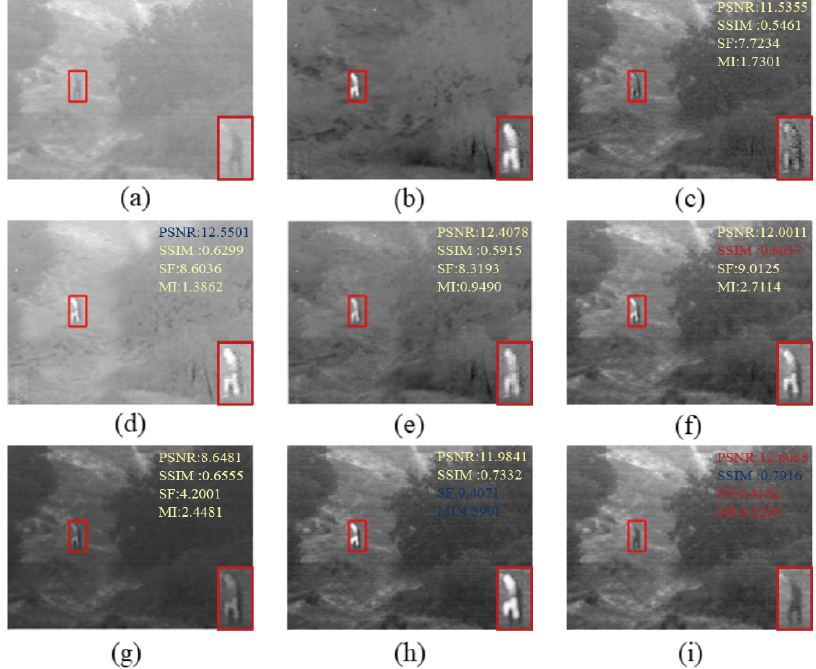
Figure 3. Qualitative comparison of LCF with six state-of-the-art methods on people. For a clear comparison, we select a salient region (i.e., the red box) in each image and enlarge it in the bottom right corner. In addition, the evaluation indicators are displayed on the top right, with red representing the best and blue the second best. ( a ) Visible image; ( b ) Infrared image; ( c ) LP; ( d ) GTF; ( e ) MSVD; ( f ) Nestfuse; ( g ) VIF; ( h ) STD; ( i )